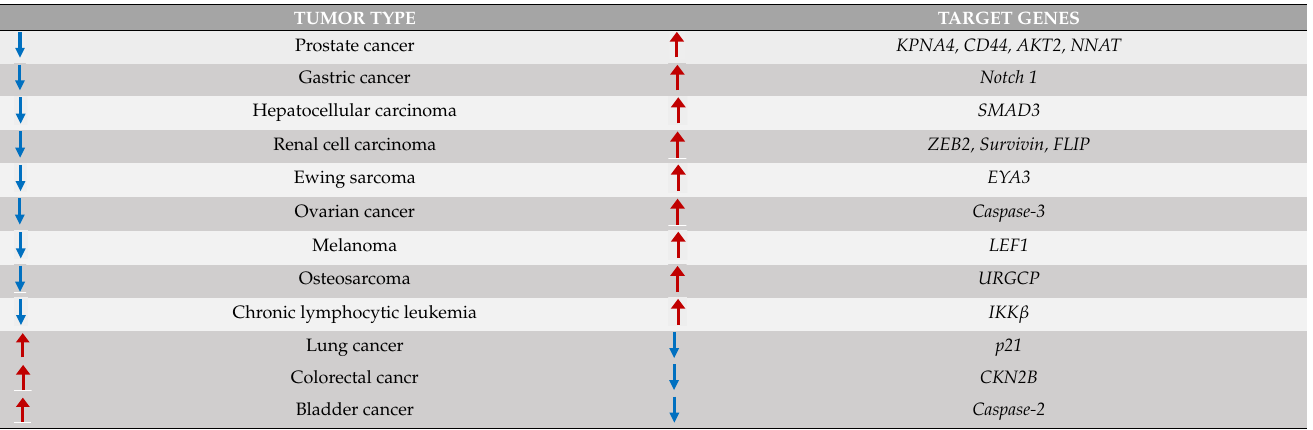
Table 1. MiR-708 target genes in different tumor types. Red arrows represent tumors in which miR- 708 or its targets are upregulated. Blue arrows represent tumors in which miR-708 or its targets are downregulated.